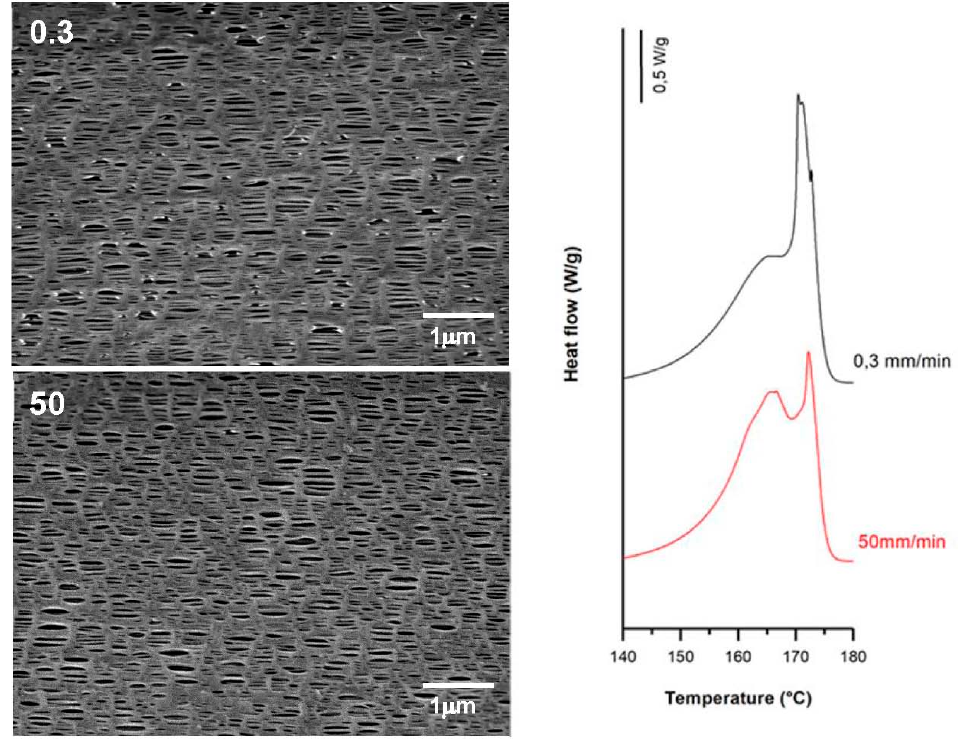
Figure 9. Influence of cold strain rate (upper-left, in mm/min). Common uniaxial strain conditions. Cold stage, 35%; hot stage, 0.3 mm/min, 320%.